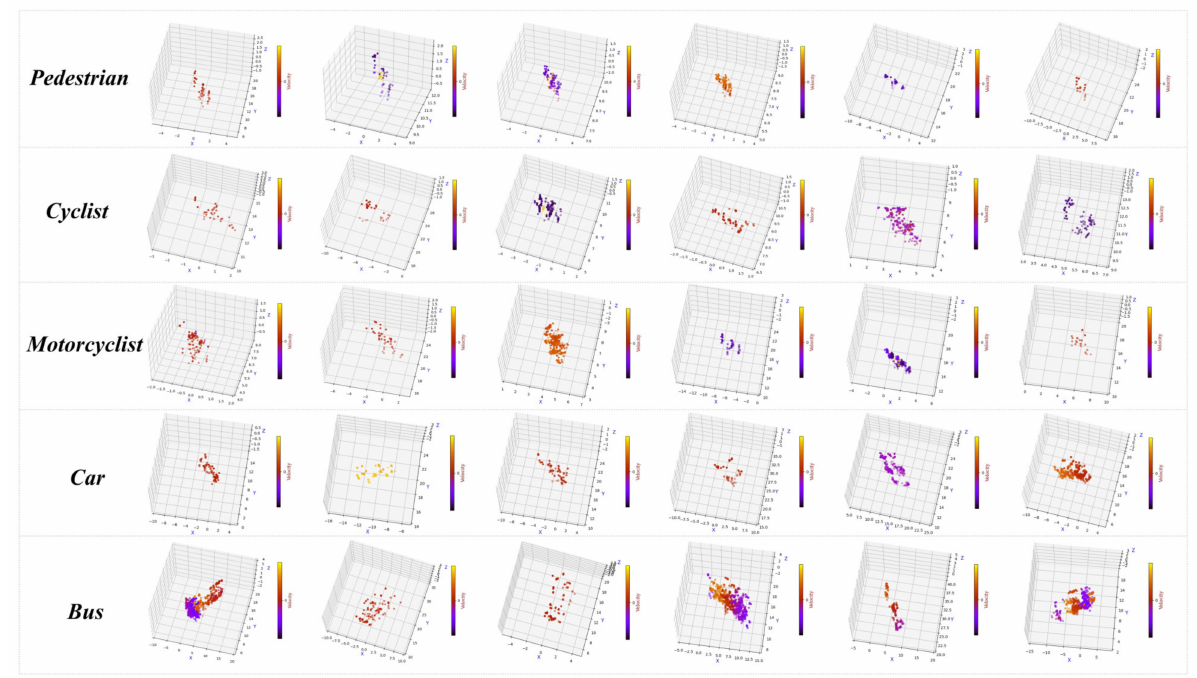
Figure 7. Visualization of some experimental